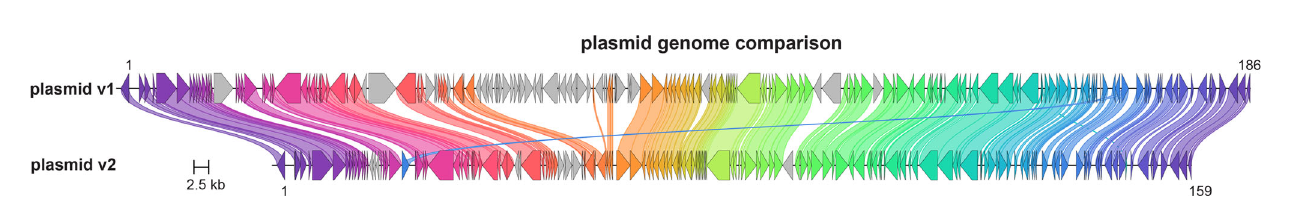
Fig.2|AlignmentofcuratedHMp_v1fromBioreactor1andHMp_v2fromBioreactor2. Coloredgeneshighlighthomologsbasedonaminoacididentity.Genenumbers are indicated at the beginning and at the